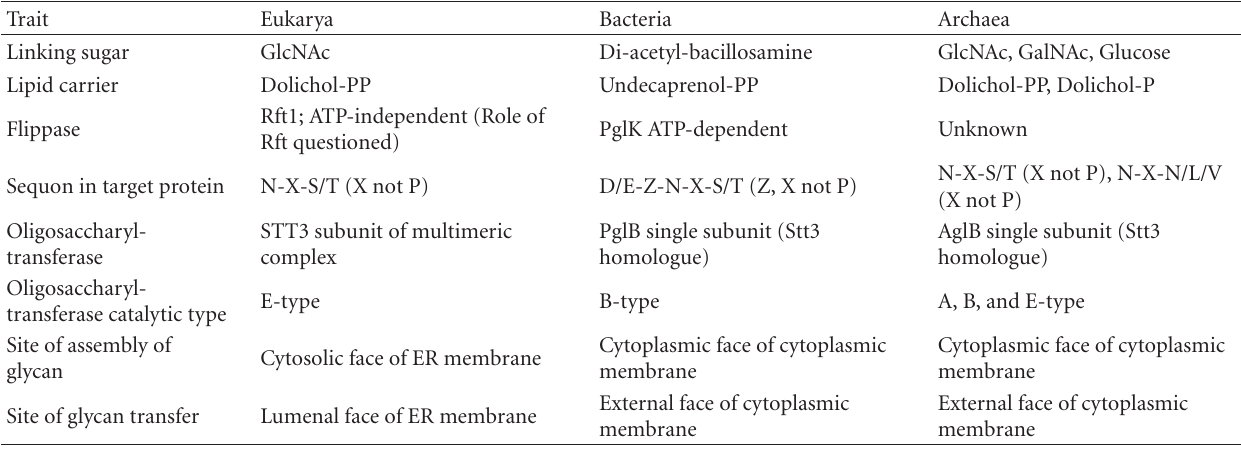
Table 1: Comparison of N-glycosylation in the three domains.